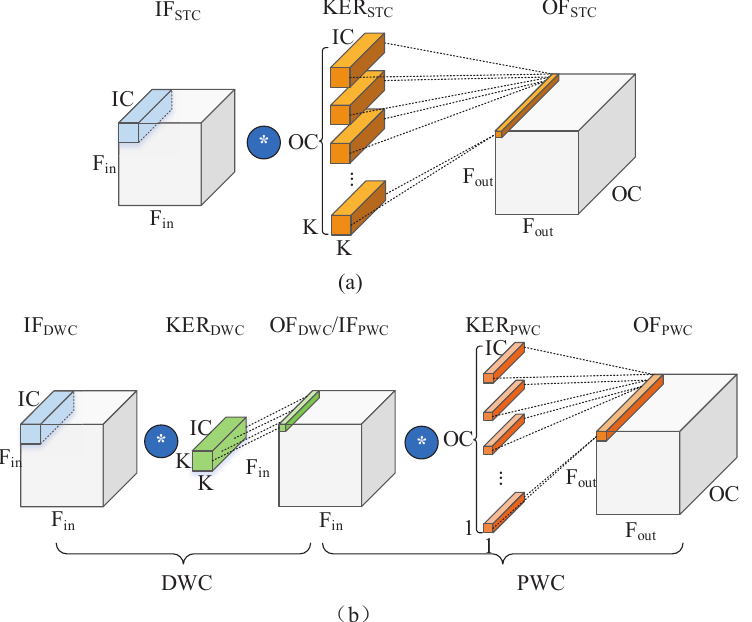
Figure 1. Comparison of the computational flow of STC and DSC. ( a ) The computational flow of standard convolution. ( b ) The computational flow of depthwise separable convolution. ( ∗ ) represents the operation of